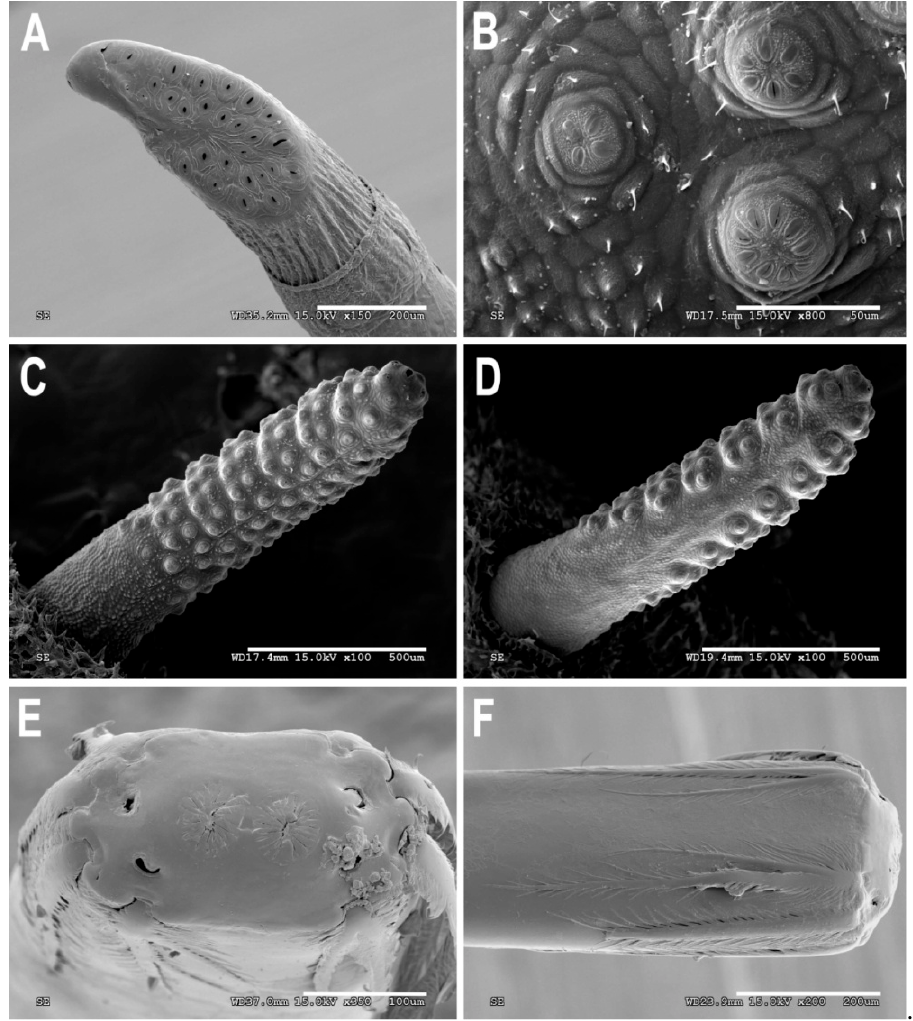
Figure 9. Meromacrus yucatense sp. nov., puparium. ( A ): anterior spiracle, ventral view. ( B ): tubercle with spiracular openings on a pupal spiracle. ( C ): pupal spiracle, dorsal view. ( D ): pupal spiracle, ventral view. ( E ): posterior respiratory process (PRP), apical view. ( F ): posterior respiratory process (PRP), dorsal view.